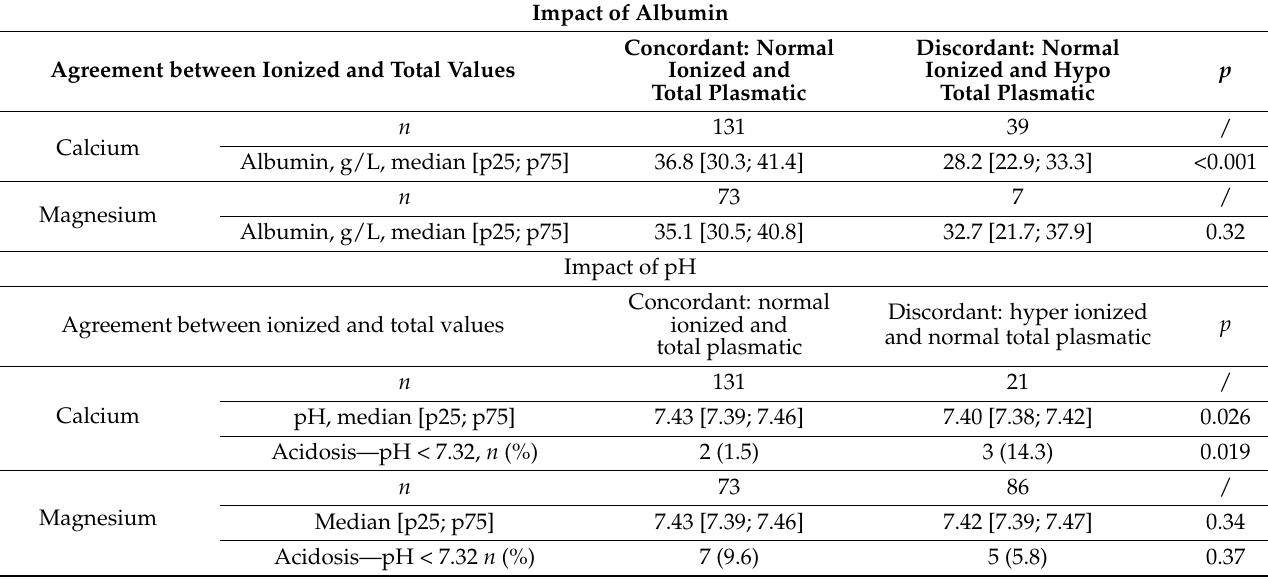
Table 2. Impact of albumin and pH on the interpretation of total plasmatic concentration of 2 divalent cations: Ca and